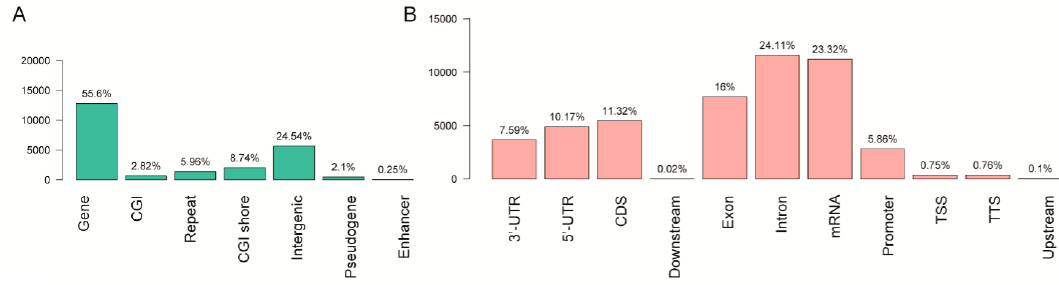
Figure 1. Cont . Figure 1.